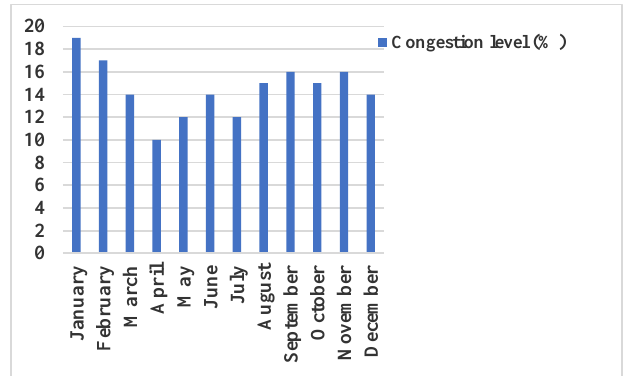
Figure 6. Congestion levels in Helsinki [113].